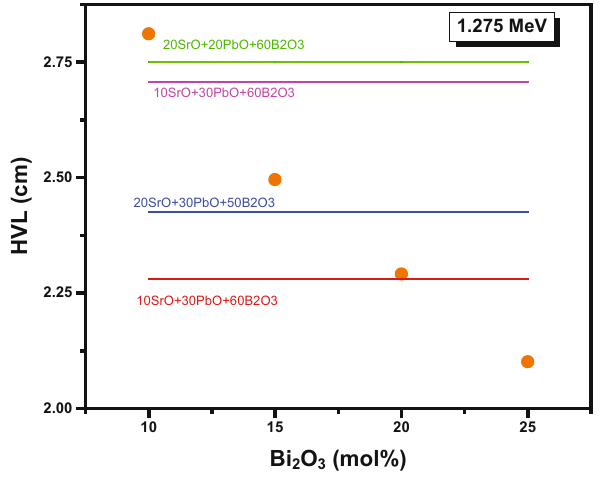
Figure 8: Comparison between the HVL for the prepared Bi 2 O 3 – PbO – CdO – B 2 O 3 glass system with the SrO – PbO – B 2 O 3 glass system at 1.275 MeV.